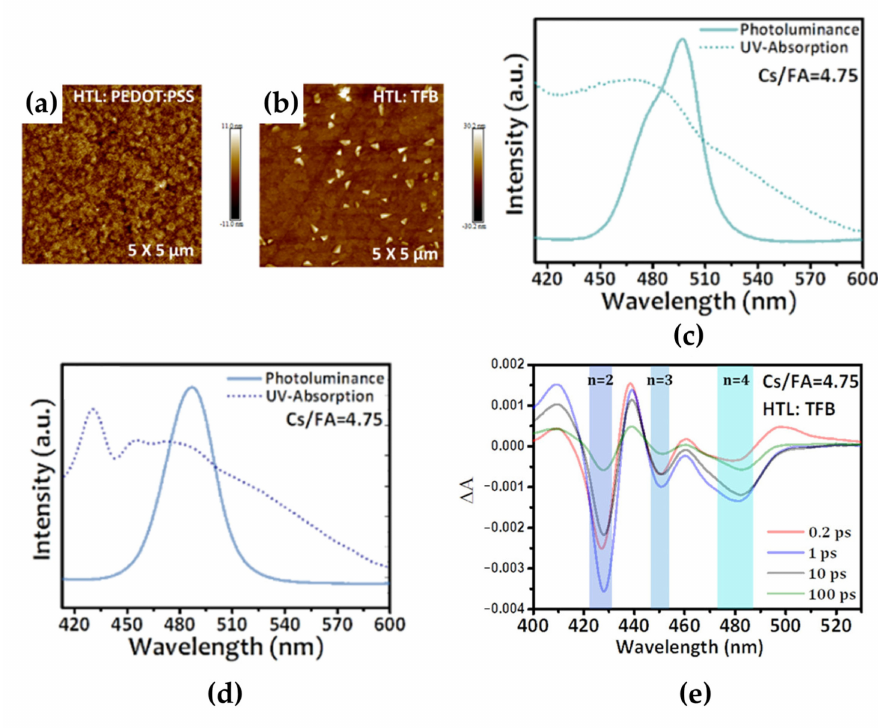
Figure 9. Atomic force topology of Cs/FA = 4.75 perovskite films on ( a ) poly(3,4- ethylenedioxythiophene):poly(styrenesulfonate) (PEDOT:PSS) and ( b ) poly[(9,9-dioctylfluorenyl-2,7- diyl)-co-(4,4-(N-(4-sec-butylphenyl)diphenylamine)] (TFB) substrates. Ultraviolet–visible absorp- tion and PL spectra of perovskite films with different precursor stoichiometry on ( c ) PEDOT:PSS and ( d ) poly(9-vinylcarbazole) (PVK) substrates. ( e ) TA spectra using different probing timescales. Reprinted with permission from [69], Copyright 2021 American Chemical